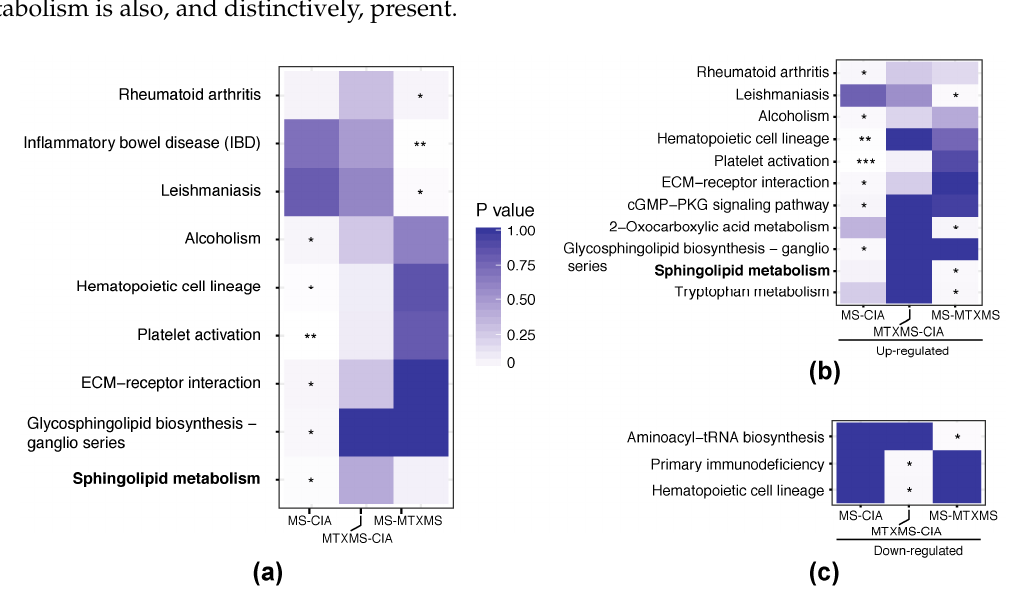
Figure 5. KEGG functional analysis of peripheral blood mononuclear cell genes. In the rows the enriched functions and in the columns the conditions compared, labeled by all differential, or increased (Up) or reduced (Down) abundance in each comparison. ( a ) KEGG pathways enriched by all differential PBMC genes; ( b ) KEGG pathways enriched by up-regulated differential PBMC genes; ( c ) KEGG pathways enriched by down-regulated differential PBMC genes. Data are represented by modified Fisher’s exact p values, p ≤ 0.001 with ***, p ≤ 0.01 with **, p ≤ 0.05 with *.